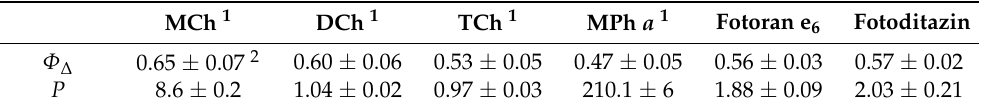
Table 1. Singlet oxygen quantum yield in OctOH and partition coefficients between OctOH and the phosphate saline buffer (pH = 7.4) for several chlorin PSs at 298 K. MCh 1 DCh